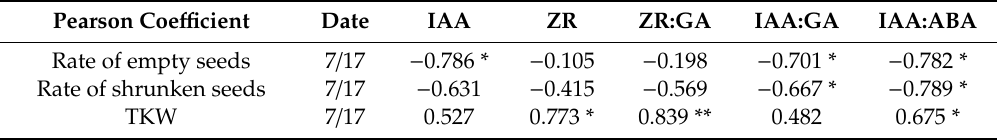
Table 2. Correlations of the endogenous hormones with rate of empty seeds, rate of shrunken seeds, and TKW ( n = 9). Pearson Coe ffi cient Date